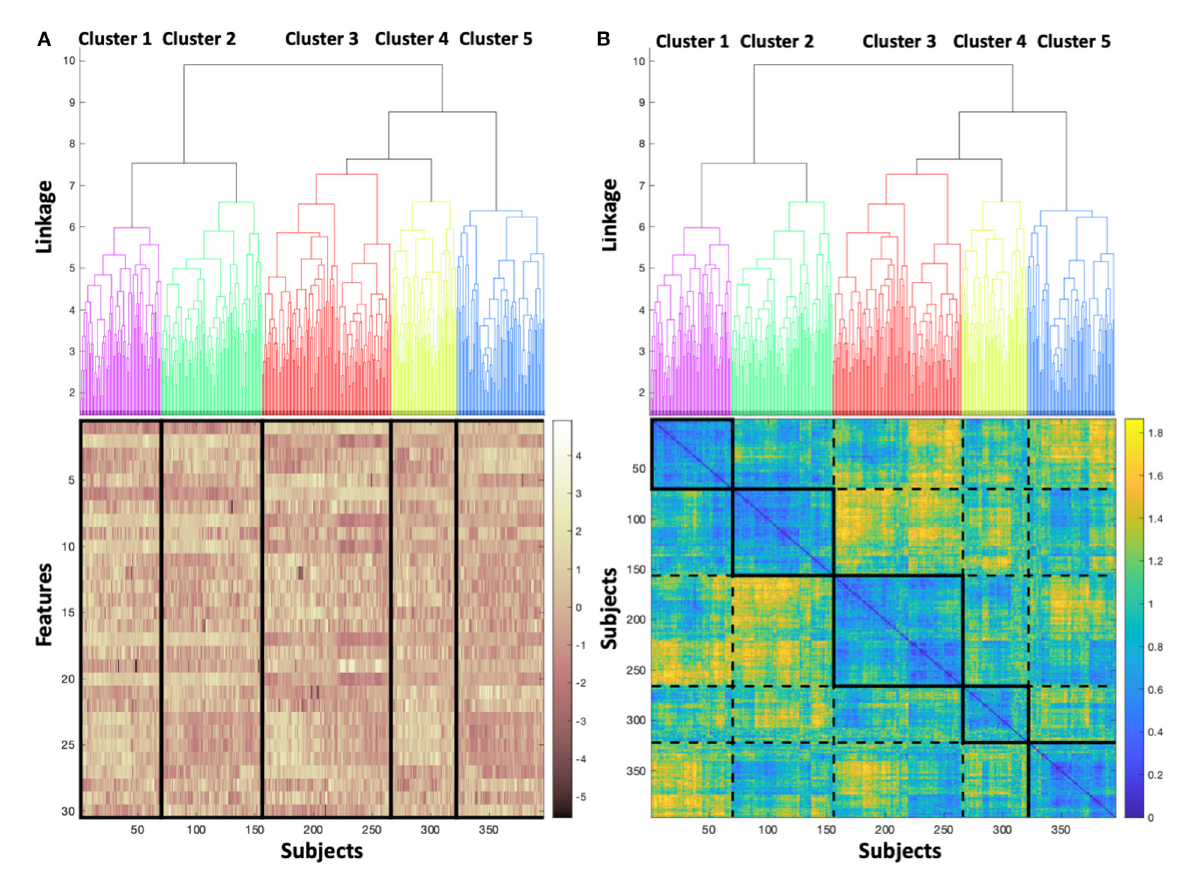
FIGURE3 (A) Dendrogram colored to identify each cluster, associated to a heatmap visualizing the magnitude of the feature values for each subject, and (B) colored dendrogram associated with the pairwise distance matrix across the dataset, with bold boxes defining each cluster, and dotted lines delineating between adjacent clusters.